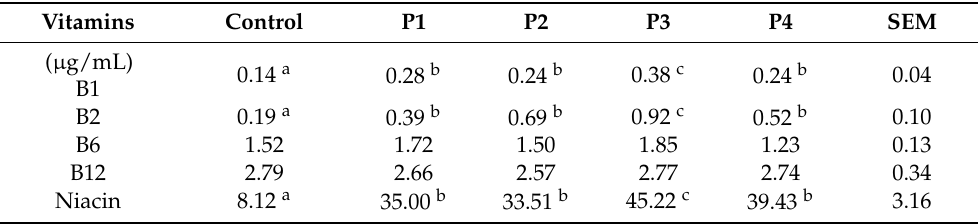
Table 6. The concentrations of ruminal B vitamins of goats fed probiotics supplementation in hot summer.